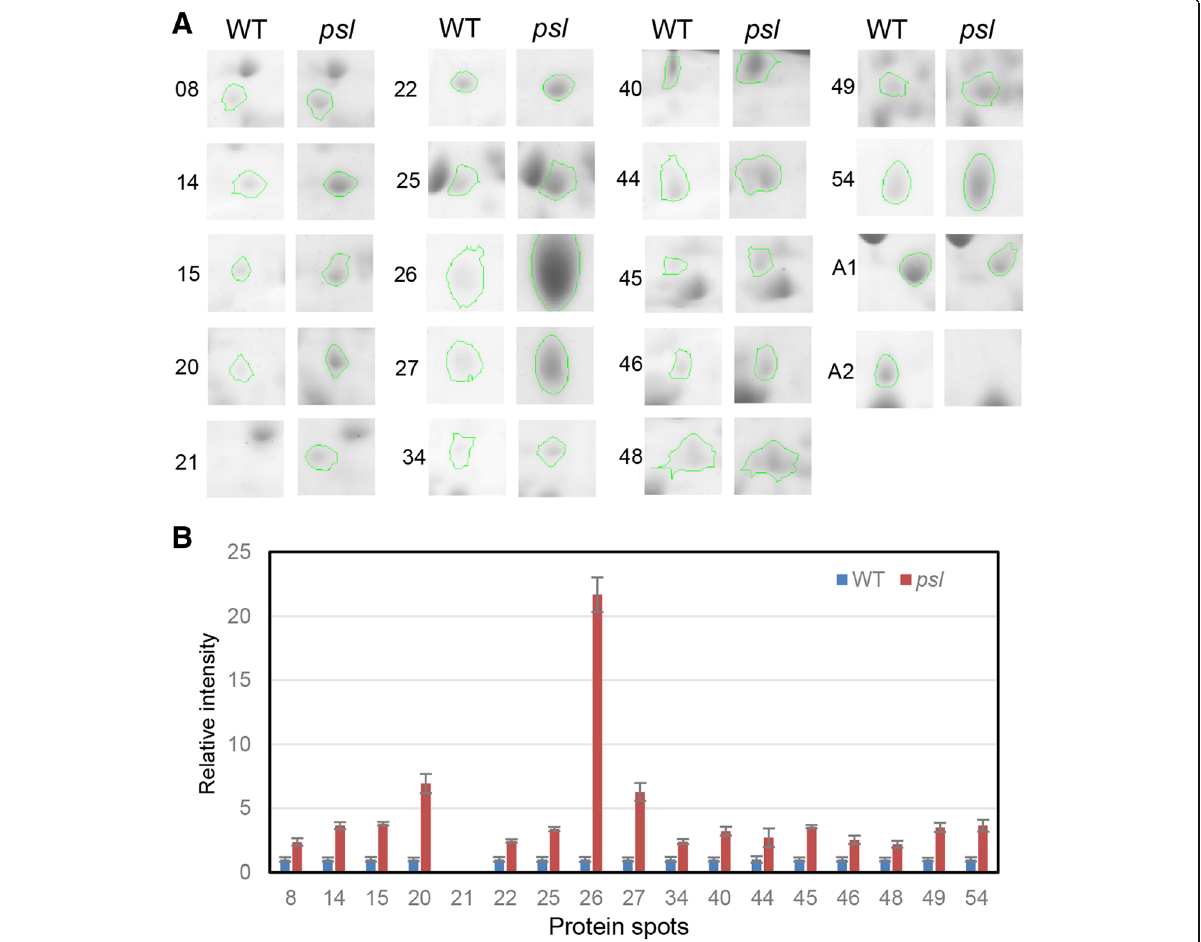
Fig. 7 2-DE analysis between WT and psl mutant. a Magnified regions of 2-DE gels. Numbers at the left of images indicate protein spots showed by arrows in Additional file 1: Figure S1 with significantly differential accumulation levels between psl and WT mutant in 2-DE gel analysis. b Quantitative analysis of differentially induced proteins on the 2-D gels. The mean relative expression level of three replicate samples is shown in the histograms based on relative protein intensities compared with background levels. Quantification of 19 protein spots from samples was made with ImageMaster 2D Platinum. Error bars indicate the standard